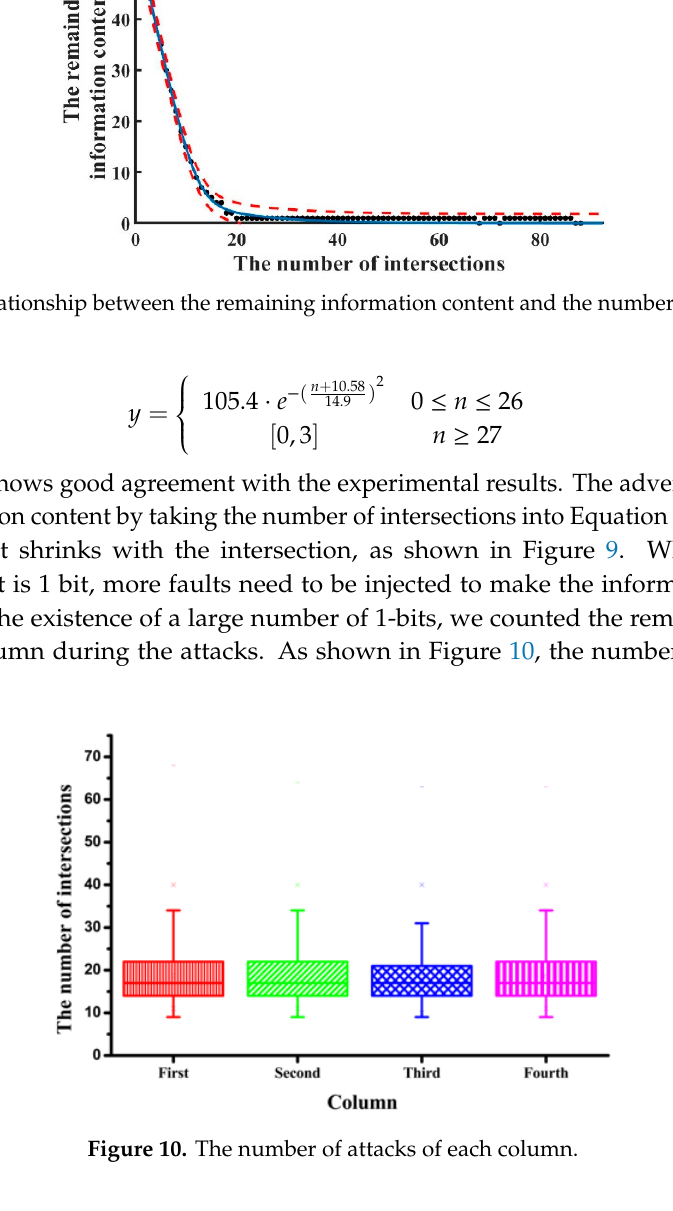
Figure 11. The relationship between the remaining information content and the number of intersections. Figure 12. The distribution of the attack time. 6. Conclusions In IoT networks, the data security of each sensor node faces severe challenges. The scattered distribution of a large number of nodes is convenient for attackers. In this paper, a novel random multiple fault attack method on Midori is proposed. The fault attack method can successfully recover the secret key in Midori with at least 11 attacks. Using computer simulation, we obtain the leakage relationship between the number of fault attacks and information content, which provides a theoretical basis for quickly obtaining the secret key. An adversary can use this function to judge the range of the remaining secret key. The random multiple fault attack method, provided in this paper